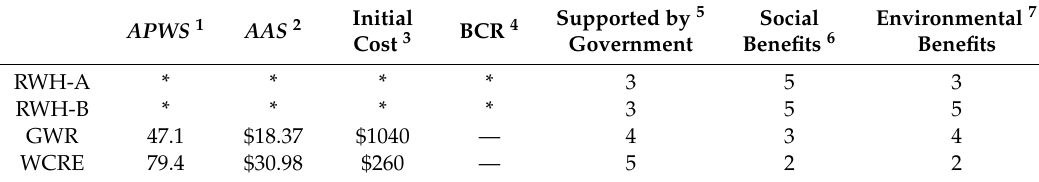
Table 3. Di ff erent water-saving methods and criteria values (decision matrix).